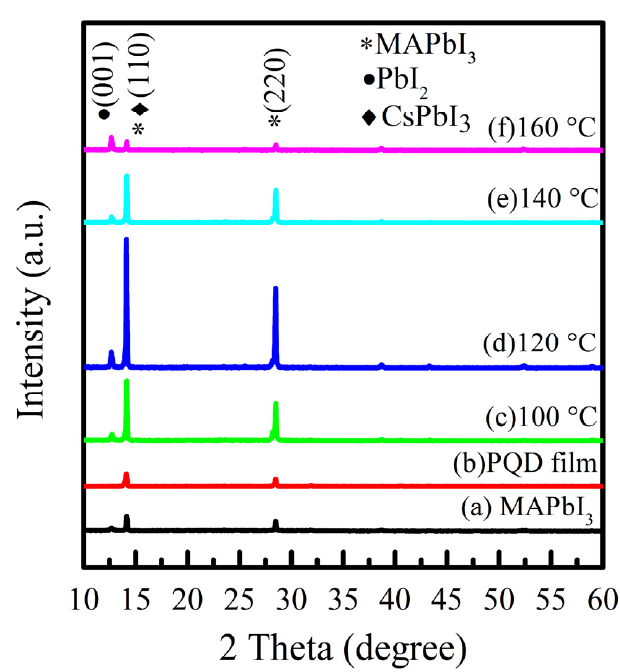
Figure 4. XRD patterns of PQD films treated at different annealing temperatures: ( a ) MAPbI 3 , ( b ) PQD film without annealing treatment, ( c – f ) PQD films annealing temperatures at 100–160 °C.